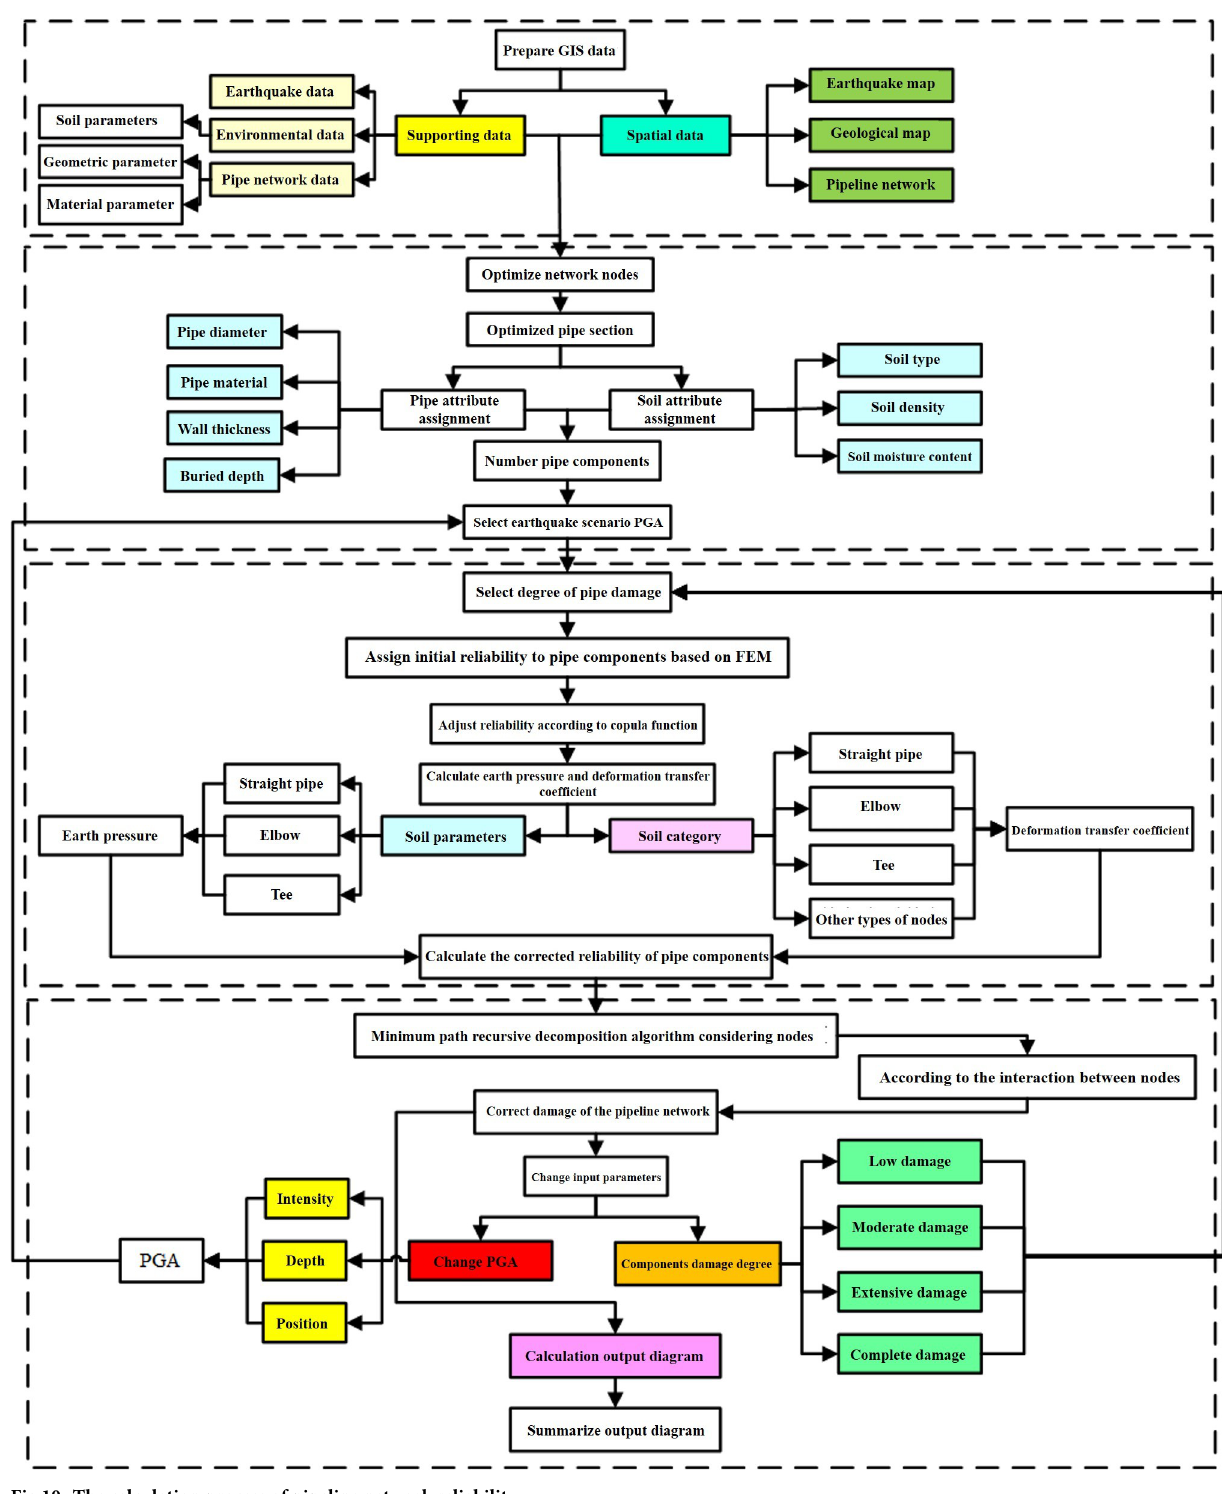
Fig 10. The calculation process of pipeline network reliability.